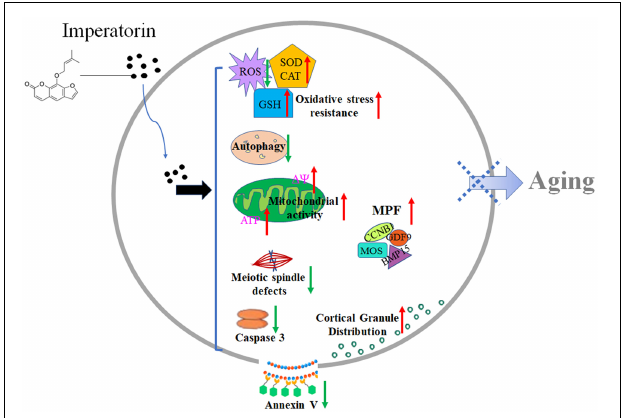
FIGURE 8 | Schematic diagram of the effects of IMP on oocyte aging. After treatment of IMP, intracellular ROS, apoptosis, and autophagy levels were decreased, while activity of CAT and SOD as well as mitochondria function (ATP production) were increased in aged oocyte. IMP-treated aged oocytes also showed significantly higher levels of MPF (MOS, CCNB1, BMP15, and GDF9) and well cortical granule distribution. These may help oocyte delay aging